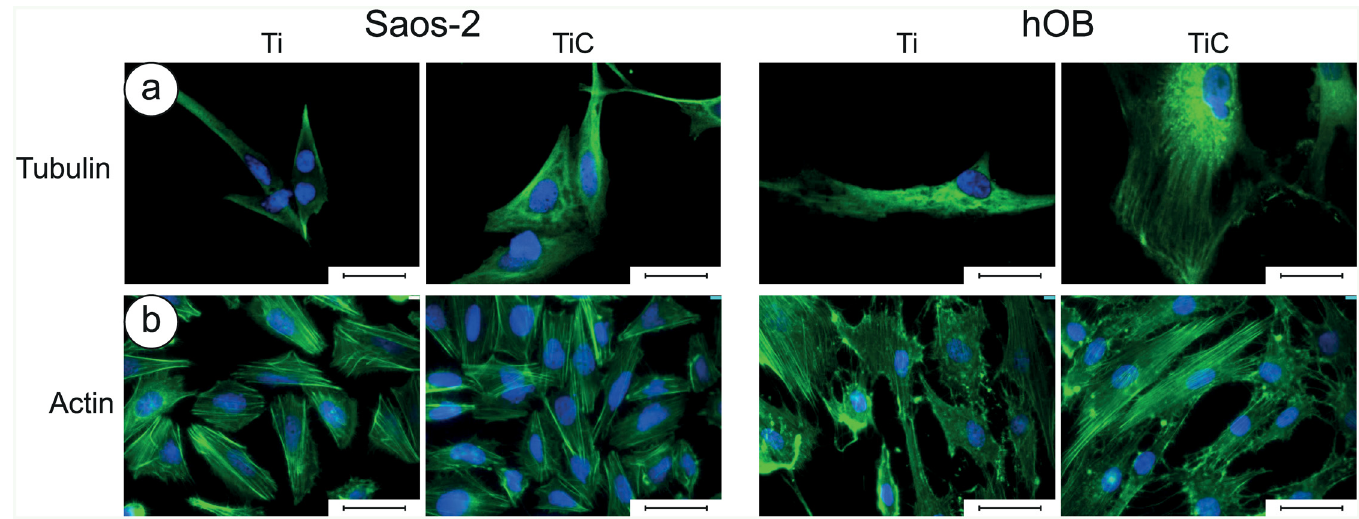
Fig 4. Immunofluorescence images of tubulin and actin in Saos-2 cells and in human primary osteoblasts. Panel a: The Saos-2 (left panels) and the hOB cells (right panels) were grown for 96 h on glass slides coated with 10.5 nm of titanium or the nanostructured TiC layer, treated with primary monoclonal antibodies against tubulin (tubulin mouse monoclonal antibody 10 μ g/ml) and Alexa Fluor 568 goat anti-mouse secondary antibodies, diluted 1:500. Panel b: The cells were treated with Phalloidyn Alexa Fluor 488-conjugated diluted 1:10. In all images, the nuclei were stained with DAPI. The images were collected with a magnification of 63X, and the bar represents 100 μ